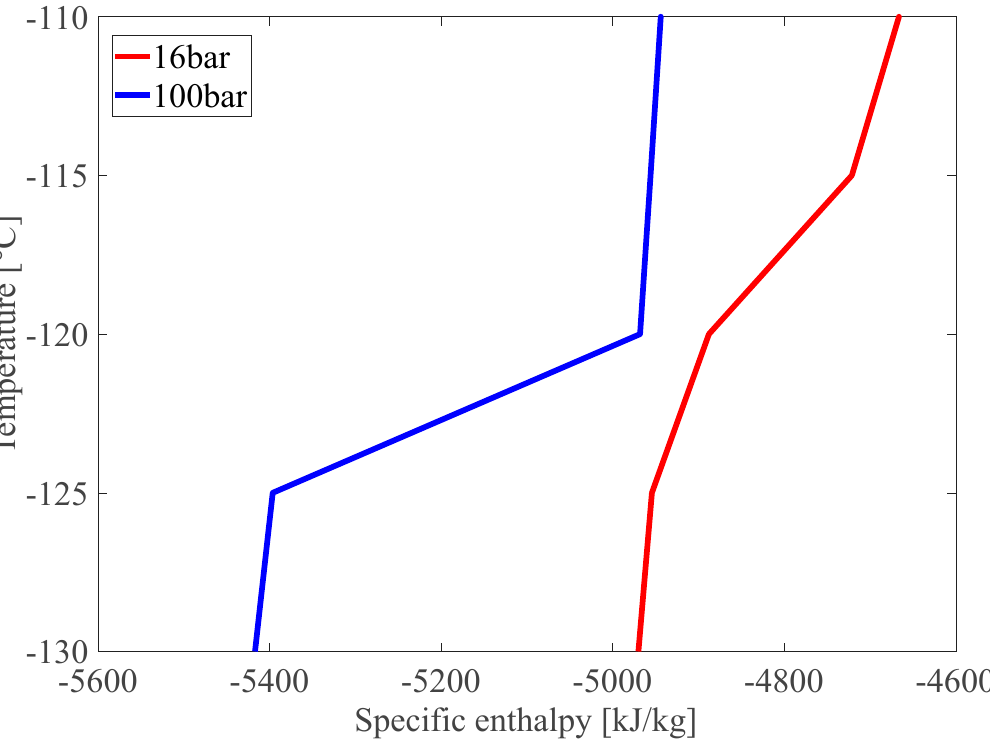
Figure 3. Temperature–enthalpy diagram for natural gas and boil-off gas. Case 3 consists of 4 refrigerants without butane. The total flow rate of the MR is 5786.3 kg/h, and after the BOG is compressed to 98.72 bar, it is cooled to − 145.4 ° C in a heat exchanger. The MR required compression to 88.7 bar, total power consumption is 526.8 kWh, and SPC is 0.5576. Compared with the previous 2 cases, a lot of energy is consumed, and as a result, the liquefaction efficiency is also low. Figure 4 shows the heat curves of the heat exchanger for case 1 and case 3, and the reason for the low efficiency can be seen in the upper right corner. Compared with case 1, the heat curve of case 3 has a lot of open upper right part, but when a refrigerant is composed without butane, the bubble point of the mixture cannot be raised to a certain level. Butane, which is heavier than propane, is required to increase the efficiency by narrowing the space on the right side, and the efficiency is lowered when butane is excluded from the mixed